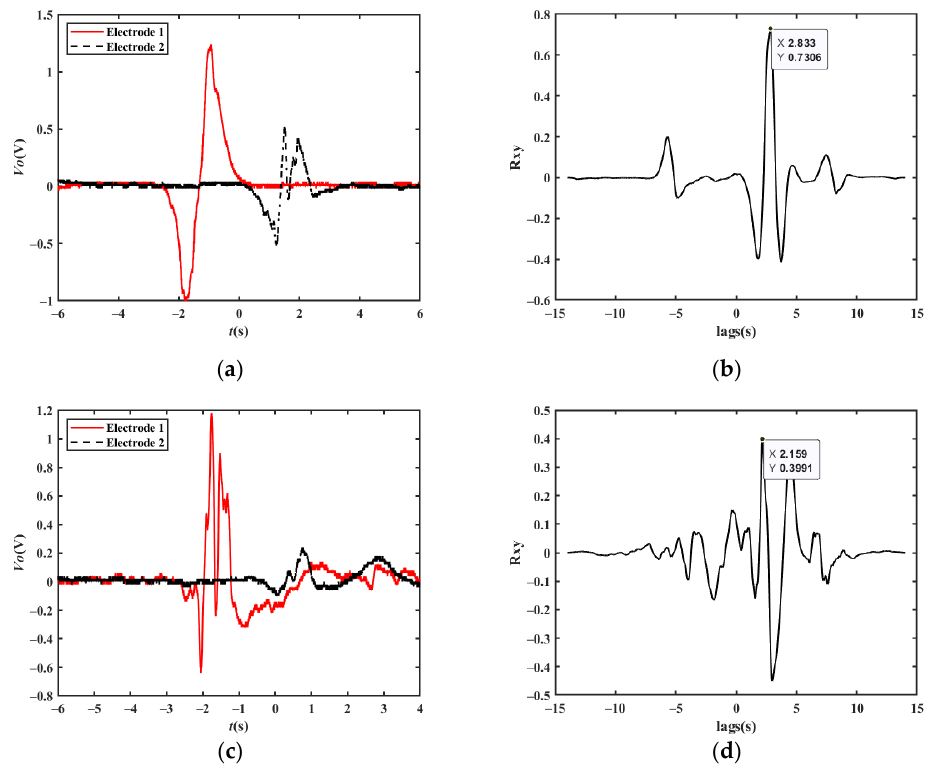
Figure 22. Experimental results in windy and rainy weather: ( a ) original waveforms at a velocity of 20 km/h; ( b ) cross-correlation results at a velocity of 20 km/h; ( c ) original waveforms at a velocity of 26 km/h with changing lanes; ( d ) cross-correlation results at a velocity of 26 km/h with changing